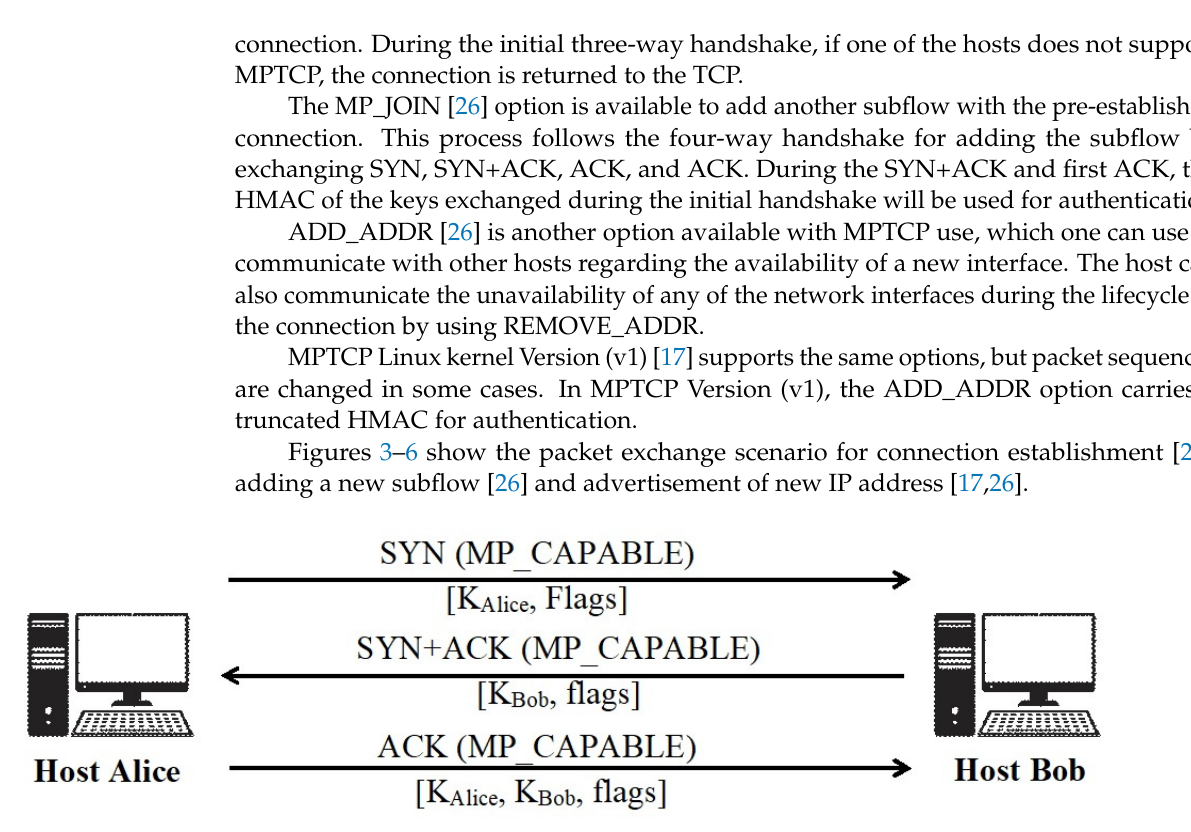
Figure 3. MPTCP Options in Version (v0) Connection Establishment with MP_CAPABLE.